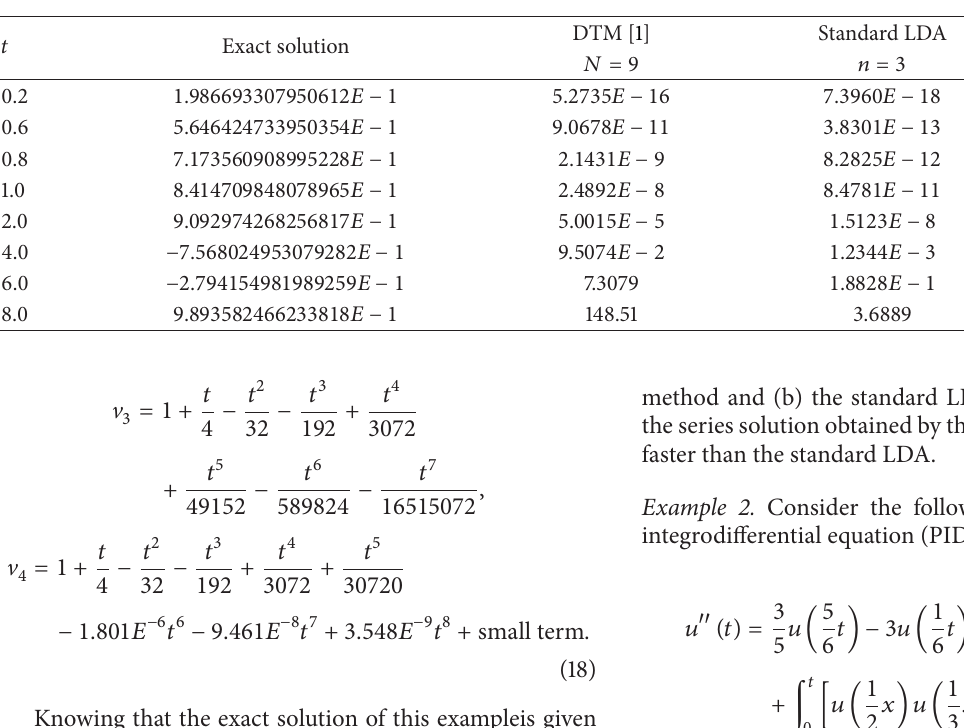
Table 2: Comparison of the absolute errors for Example